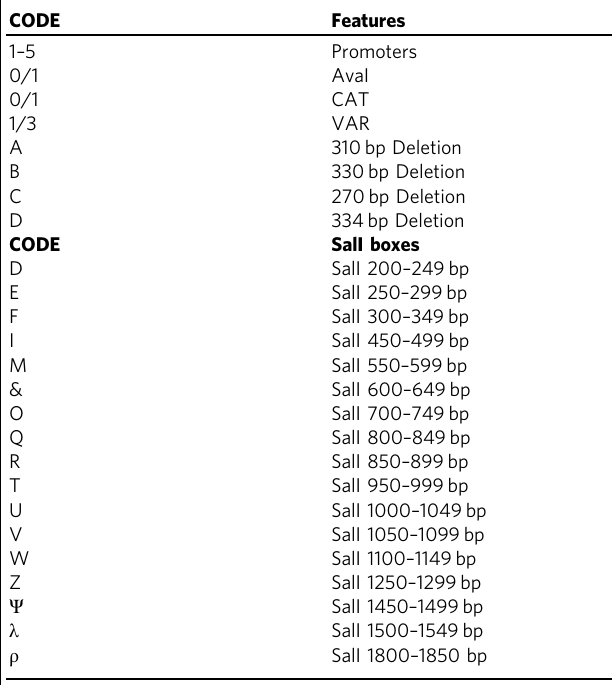
Table 1 Glossary for the alphanumeric feature classi fi